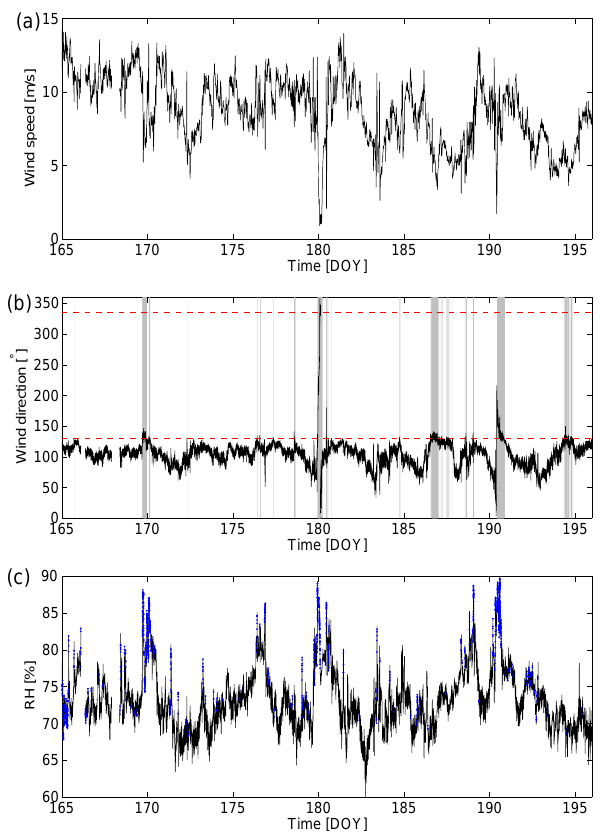
Figure 1. Local meteorological parameters measured at the top of the 17m high tower: (a) wind speed; (b) wind direction. The grey shades indicate time periods during which influence from local sources cannot be ruled out (wind directions in the range from 130 to 335 ◦ ). Wind directions of 130 and 335 ◦ are indicated by horizon- tal dashed red lines. (c) The measured relative humidity with blue points indicating time periods with